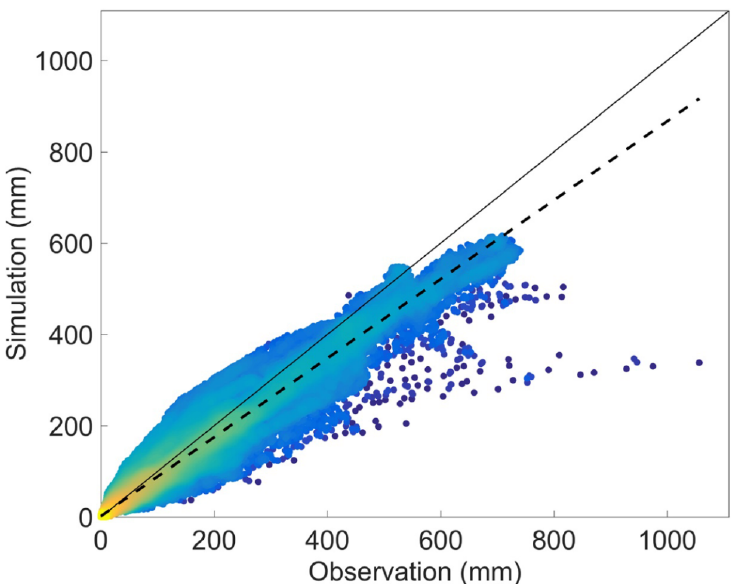
Figure A3. Correlation between mean historical tropical cyclone rainfall and simulated tropical cyclone rainfall for 1980–2020, where the solid line is the 1:1 line and the dashed line is the slope of the fit.